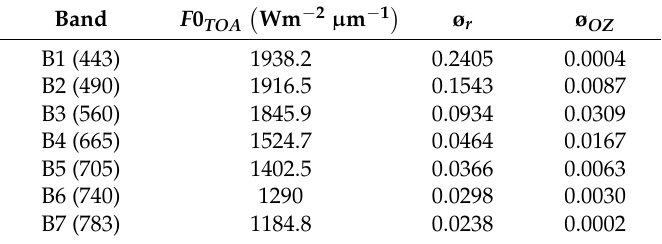
Table 6. Example of the parameters obtained and used during the atmospheric simulation for the MSI sensor. F 0 TOA is the band-weighted extraterrestrial solar irradiance, τ r is the Rayleigh optical thickness for a standard atmosphere, and τ OZ is the ozone optical thickness for 300 DU of atmospheric